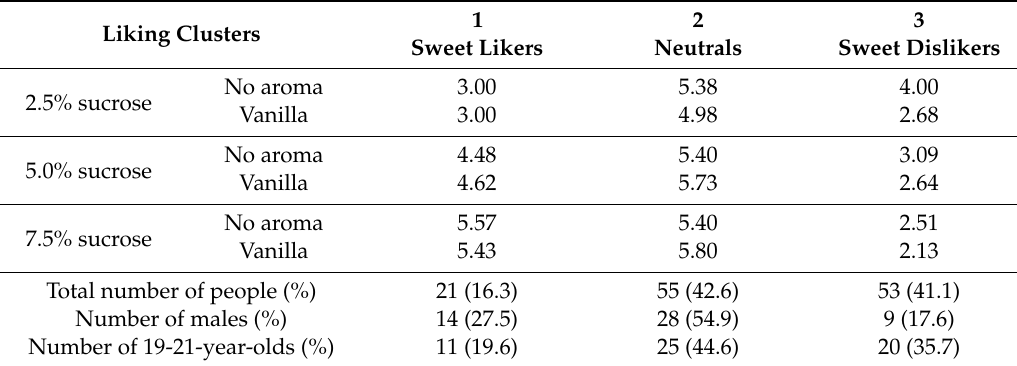
Table 4. Cluster liking centroids for each sample together with the demographics for each cluster. Numbers in brackets shows the percentages from the total number of people, males, and 19–21-year-olds, respectively.